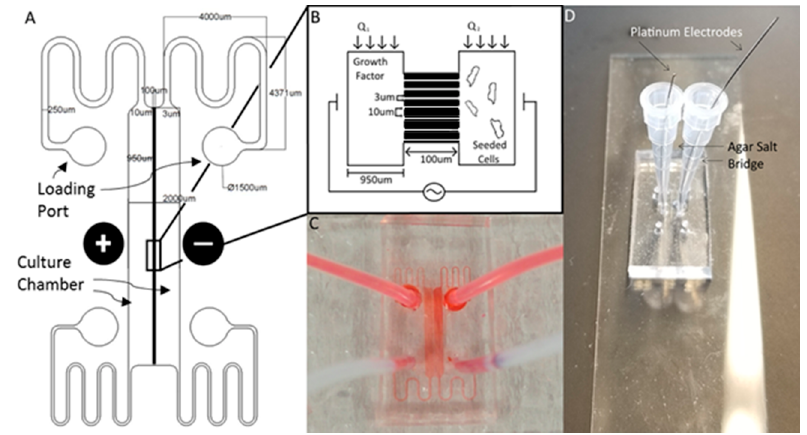
Figure 1. The Gal-MµS. ( A ) Schematic of the design illustrating channel arrays separating two culture chambers. Electrodes are placed on either side of the culture chambers to facilitate controlled application of electric fields. ( B ) Cartoon schematic illustrating Gal-MµS operation, not to scale. Cells are loaded into one culture chamber, while the desired chemical stimulant is loaded into the other. Establishing